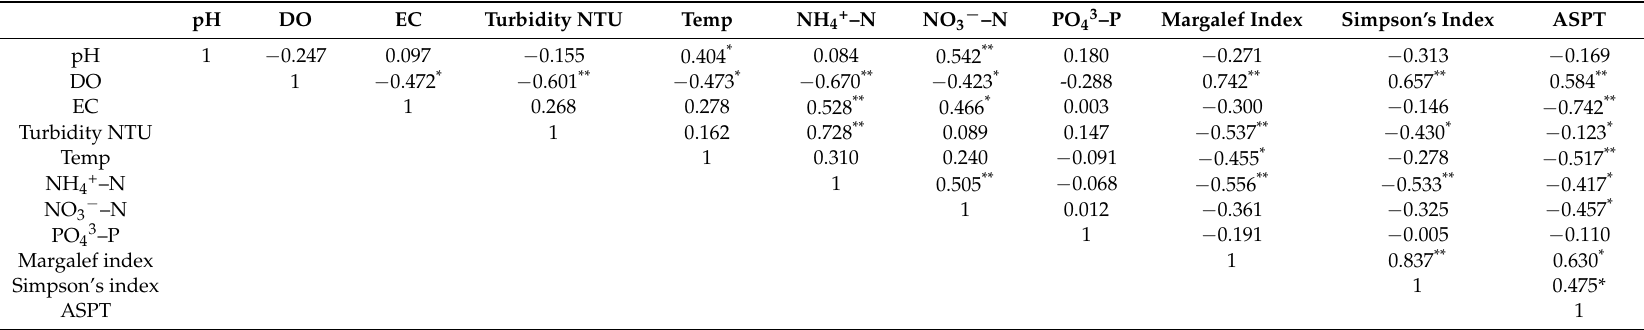
Table 2. Spearman correlation between physical-chemical parameters, species richness, and diversity ASPT based on data from five streams in irrigation systems in Kilombero valley. Negative correlations are highlighted in red, and positive correlations in